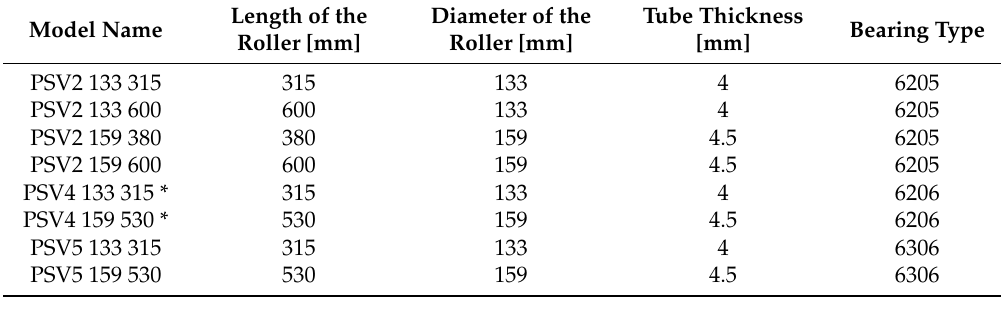
Table 1. Geometrical parameters of the rollers considered in the present investigation and in Ref. [38] (*).